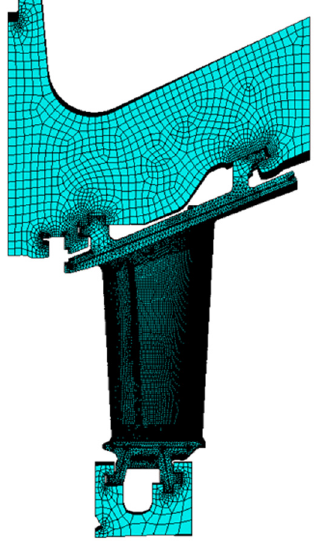
Figure 1. Flowchart of the whole crack growth procedure on the studied component.